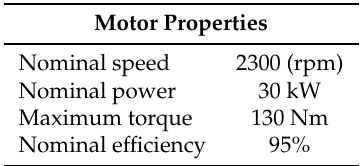
Table 3. Electric motor characteristics.